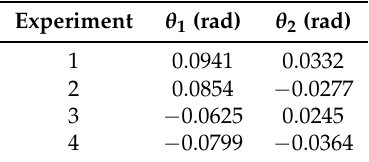
Table 3. Selected positions for static